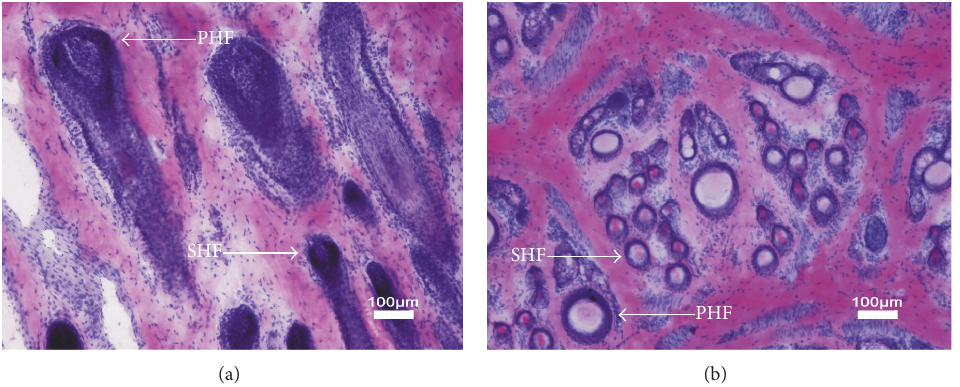
Figure 1: Frozen sections of cashmere goat skin stained by hematoxylin. White arrows indicate the primary hair follicles (PHFs) and secondary hair follicles (SHFs) in the